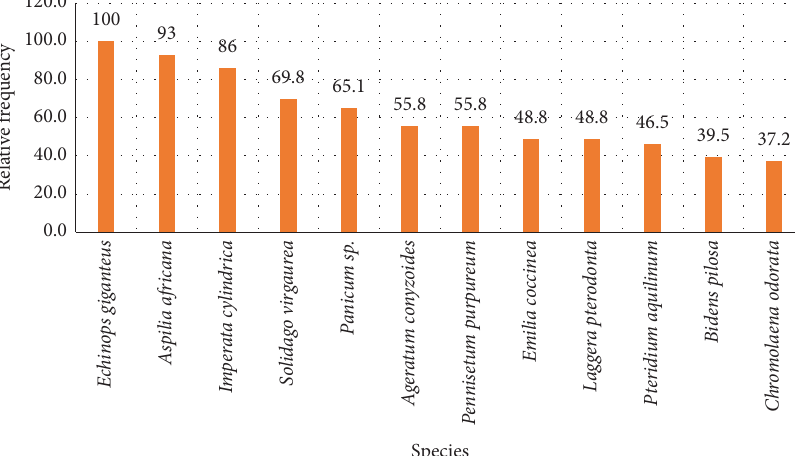
Figure 7: Relative frequency of the most represented species.